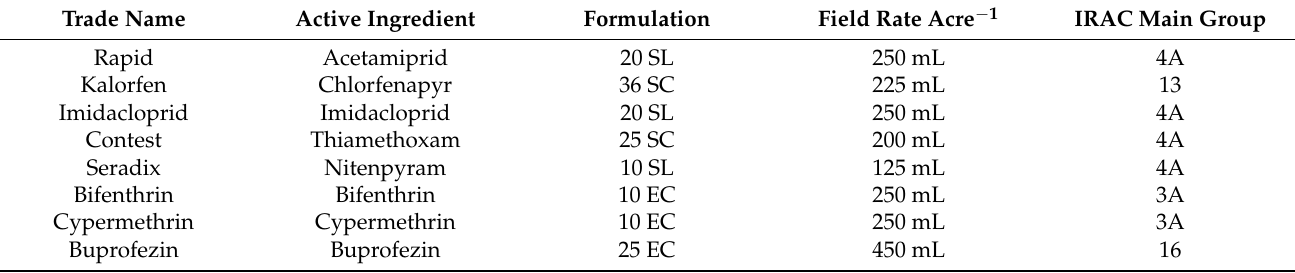
Table 1. Trade name, active ingredients (AI), formulation, Field rate and IRAC main group of selected insecticides. Trade